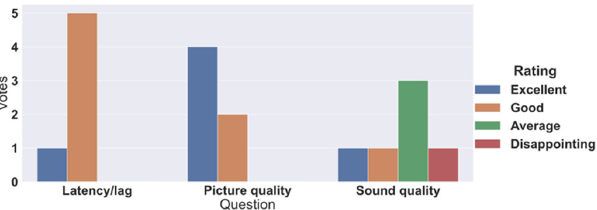
Figure 12 Survey results about the remote